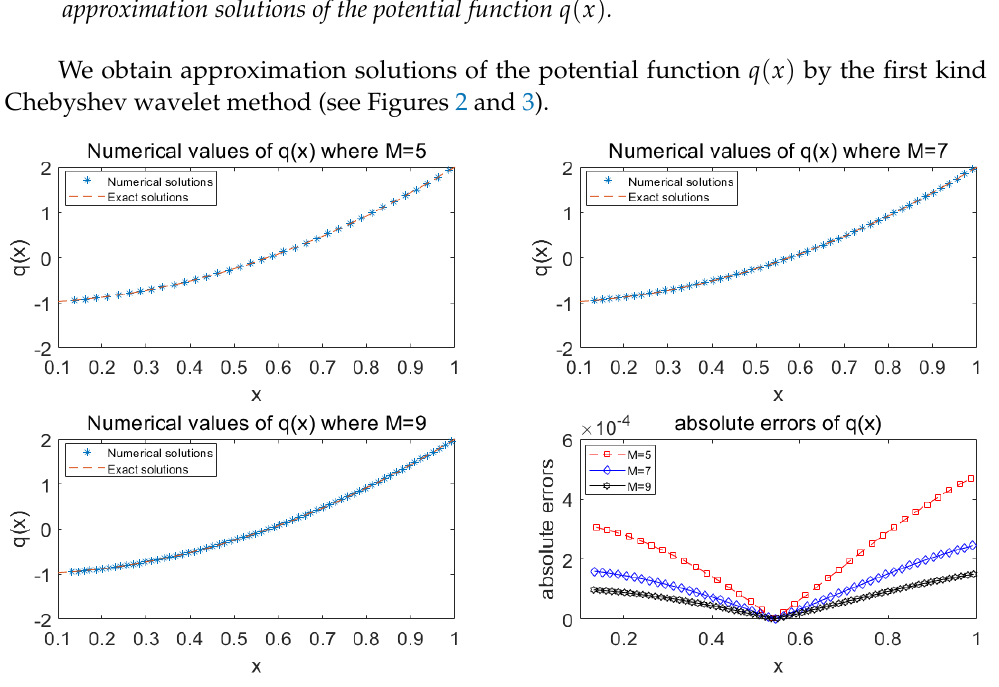
Figure 2. Numerical values of q ( x ) and absolute errors between the approximation and exact solutions of q ( x ) with k = 4 and M = 5, 7, 9 in Example 2.